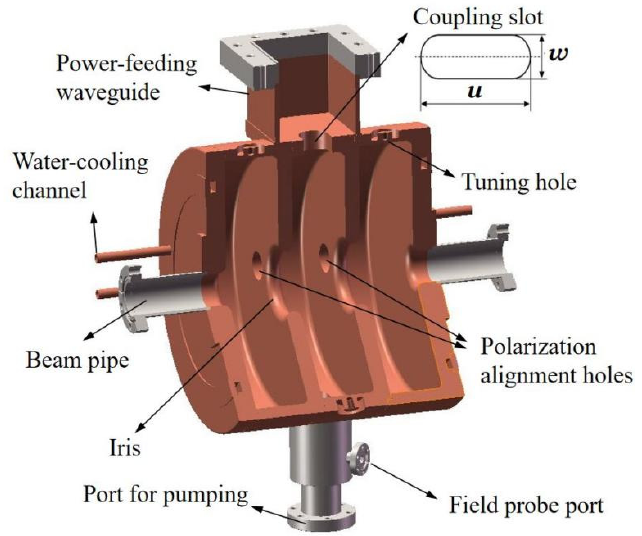
Figure 7. Three-dimensional mechanical model of the deflecting cavity.